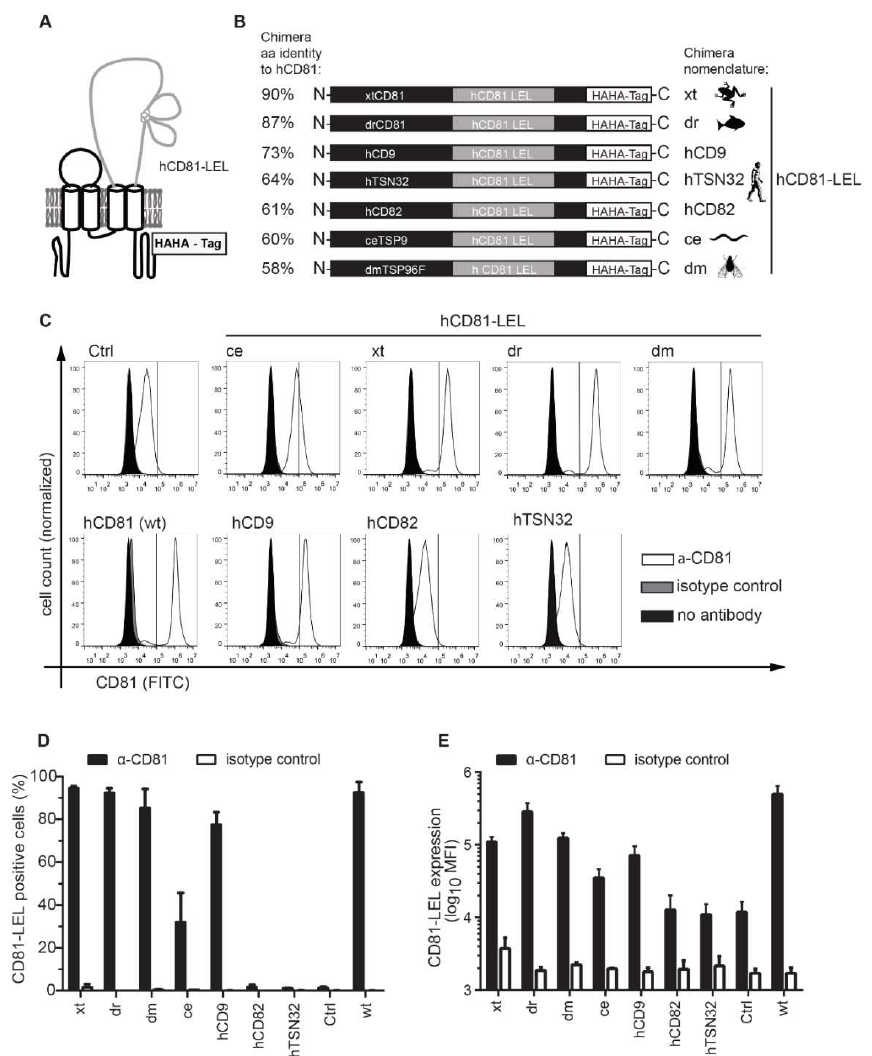
Figure 1. Expression of hCD81 chimeras on CHO745 cells. ( A ) Schematic representation of the hCD81 chimeras used in this study; ( B ) Amino acid sequence identities calculated by Clustal W and domain structure of the chimeras; ( C ) Flow cytometric analysis of surface expression on CHO745 cells. Cells were transduced with the indicated hCD81 chimeras, full-length hCD81 (wt) or empty vector (Ctrl) and selected with blasticidin. CD81 surface expression was determined by staining with an antibody directed against the hCD81 LEL (clone JS-81). The histograms show cells stained with anti-hCD81, an isotype control antibody or cells left unstained. Vertical lines indicate gating for CD81 positive cells; ( D ) Quantitation of hCD81 surface staining depicted as percentage of positive cells or ( E ) as mean fluorescence intensity (MFI). Mean values + SD of three independent biological replicates are shown in ( D , E ). The histograms show one out of three representative experiments with 30,000 cells per measurement.